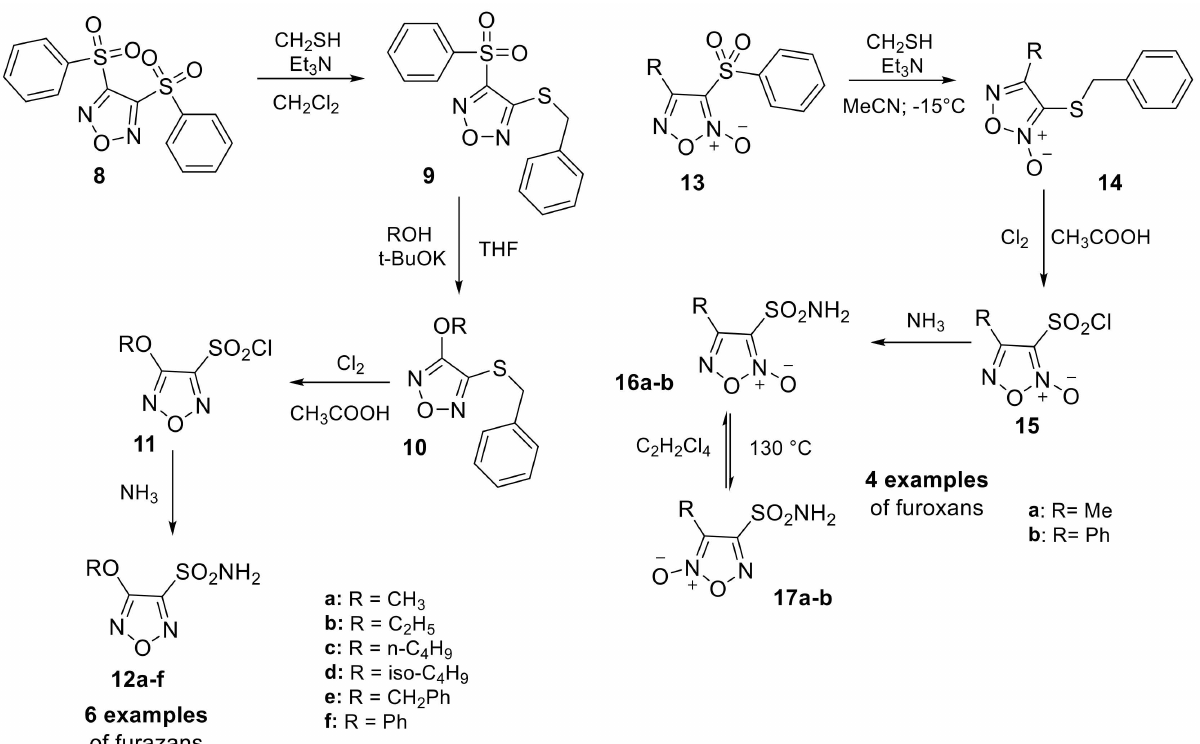
Scheme 4. Schematic synthesis of furazan ( 12a – f ) and (furoxan 16a – b and 17a – b ) sulfonamides